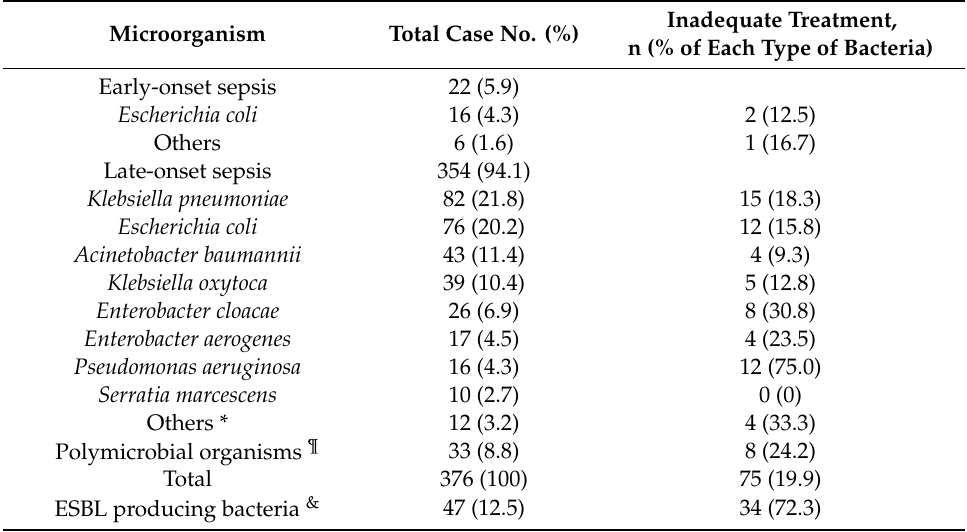
Inadequate Treatment, n (% of Each Type of Bacteria)